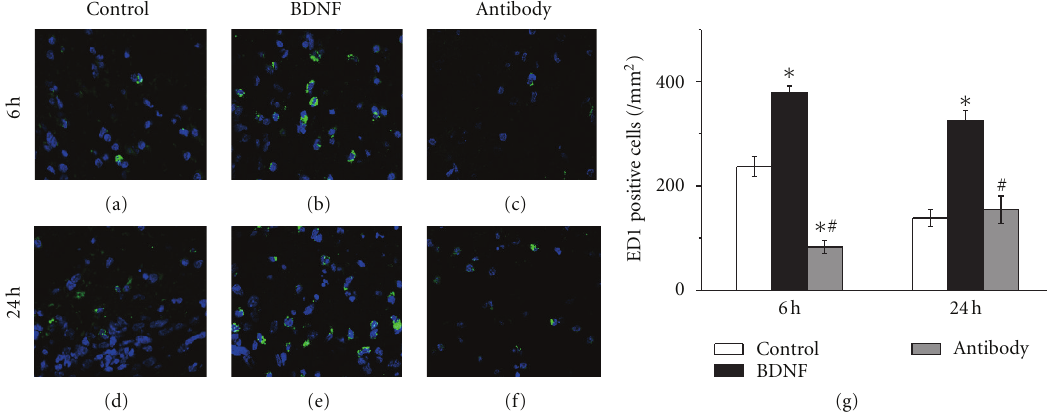
Figure 4: BDNF upregulating the number of phagocytotic microglia after stroke ED1 is well known as a marker of phagocytotic microglia. (a–c) 6h after reperfusion and (d–f) 24h after reperfusion; (a, d) control group, (b, e) BDNF group and (c, f) antibody group. BDNF significantly increased the number of phagocytotic microglia in brain 6h and 24h after reperfusion. The number of activated microglia was decreased in BDNF antibody group at 6h of reperfusion. Bars represent mean ± SD ( n = 6). ∗ P < . 05 versus control group, # P < . 05 versus BDNF group. Scale bars: 25 μ